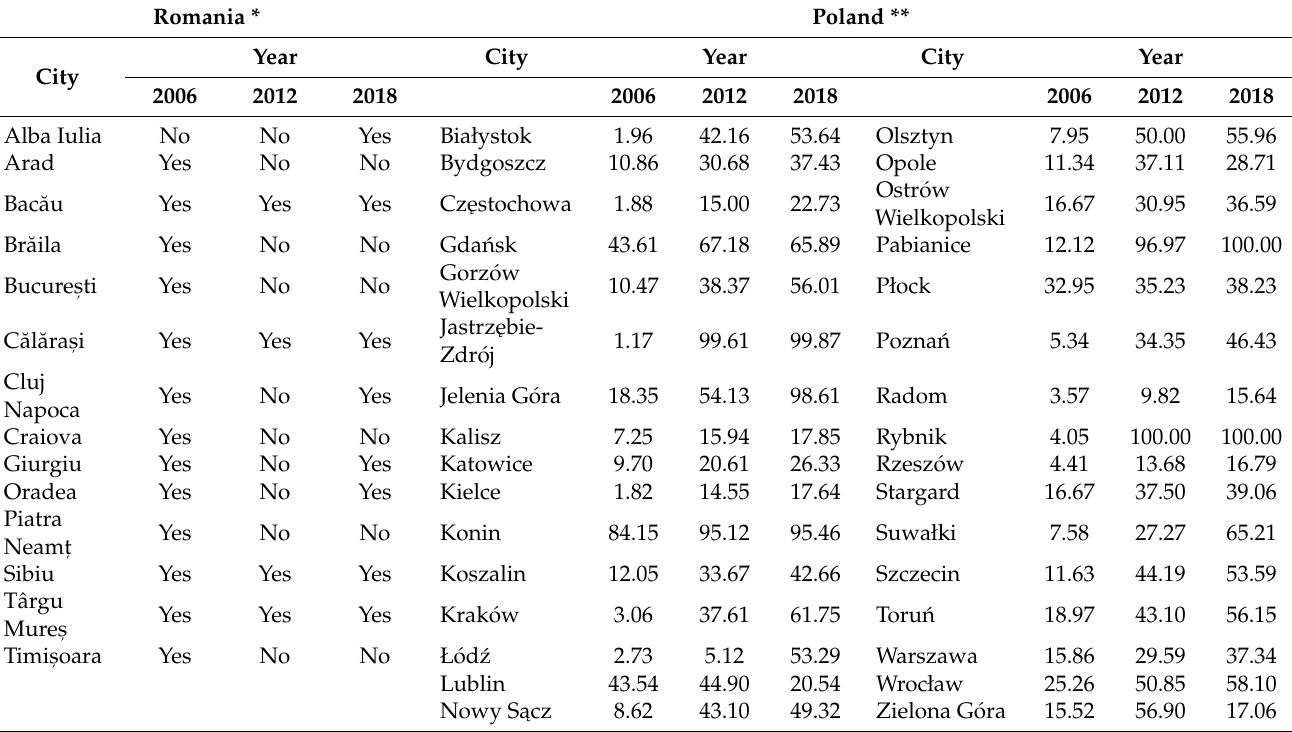
Table 6. Planning status of the studied cities, according to the different planning systems in each country: existence of an up-to-date plan in Romania and share of the planned area from the city area in Poland. Romania